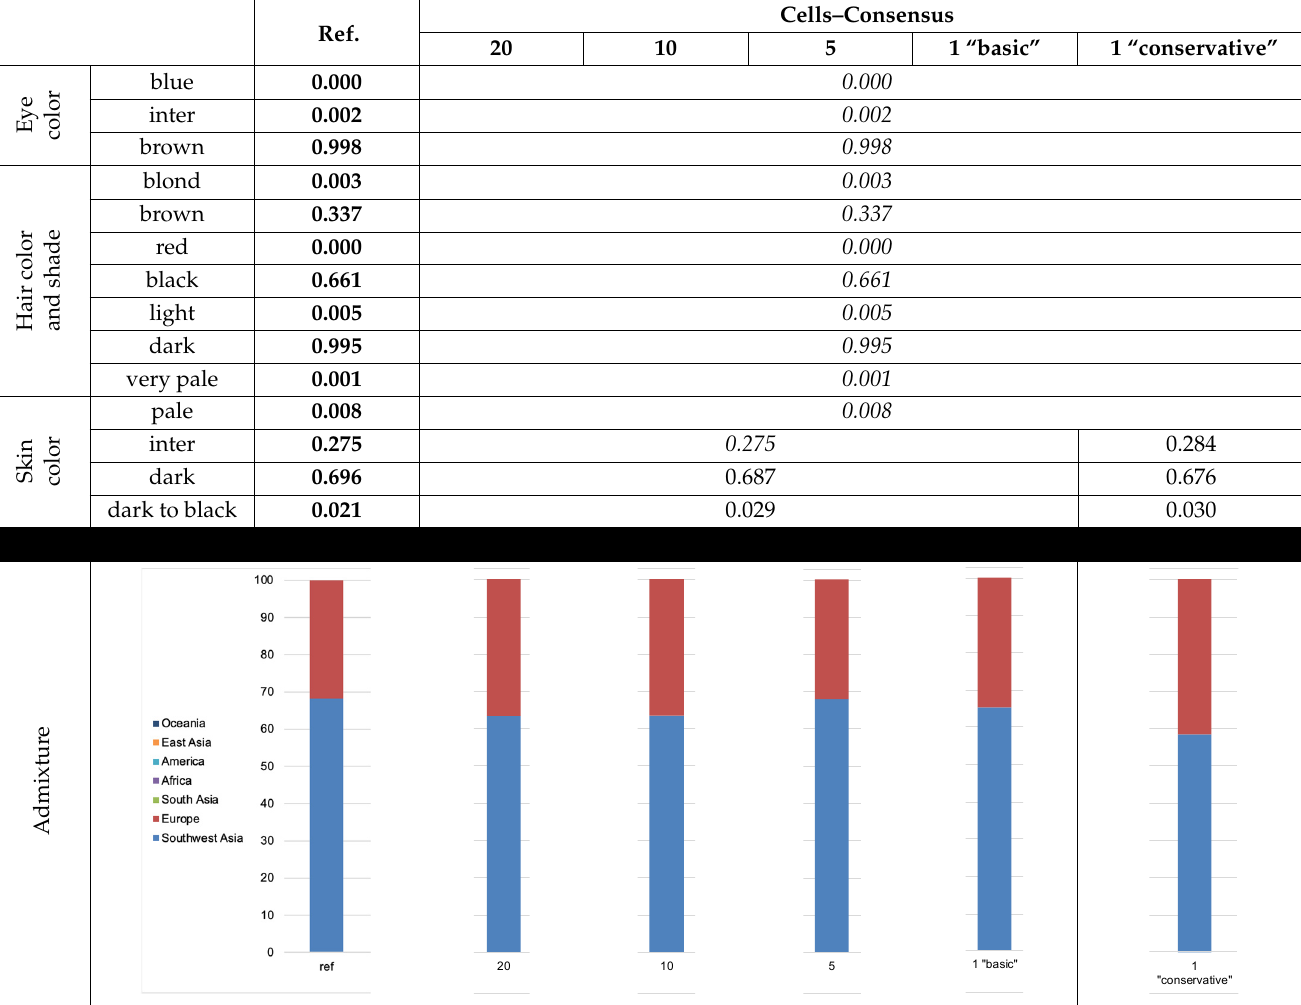
Table 1. Phenotype and ancestry prediction summary for cell groups and consensus profiles from single cells. p -values and admixture proportions were compared with the results obtained for reference (ref.) sample ( italic indicates identical values). Ref.